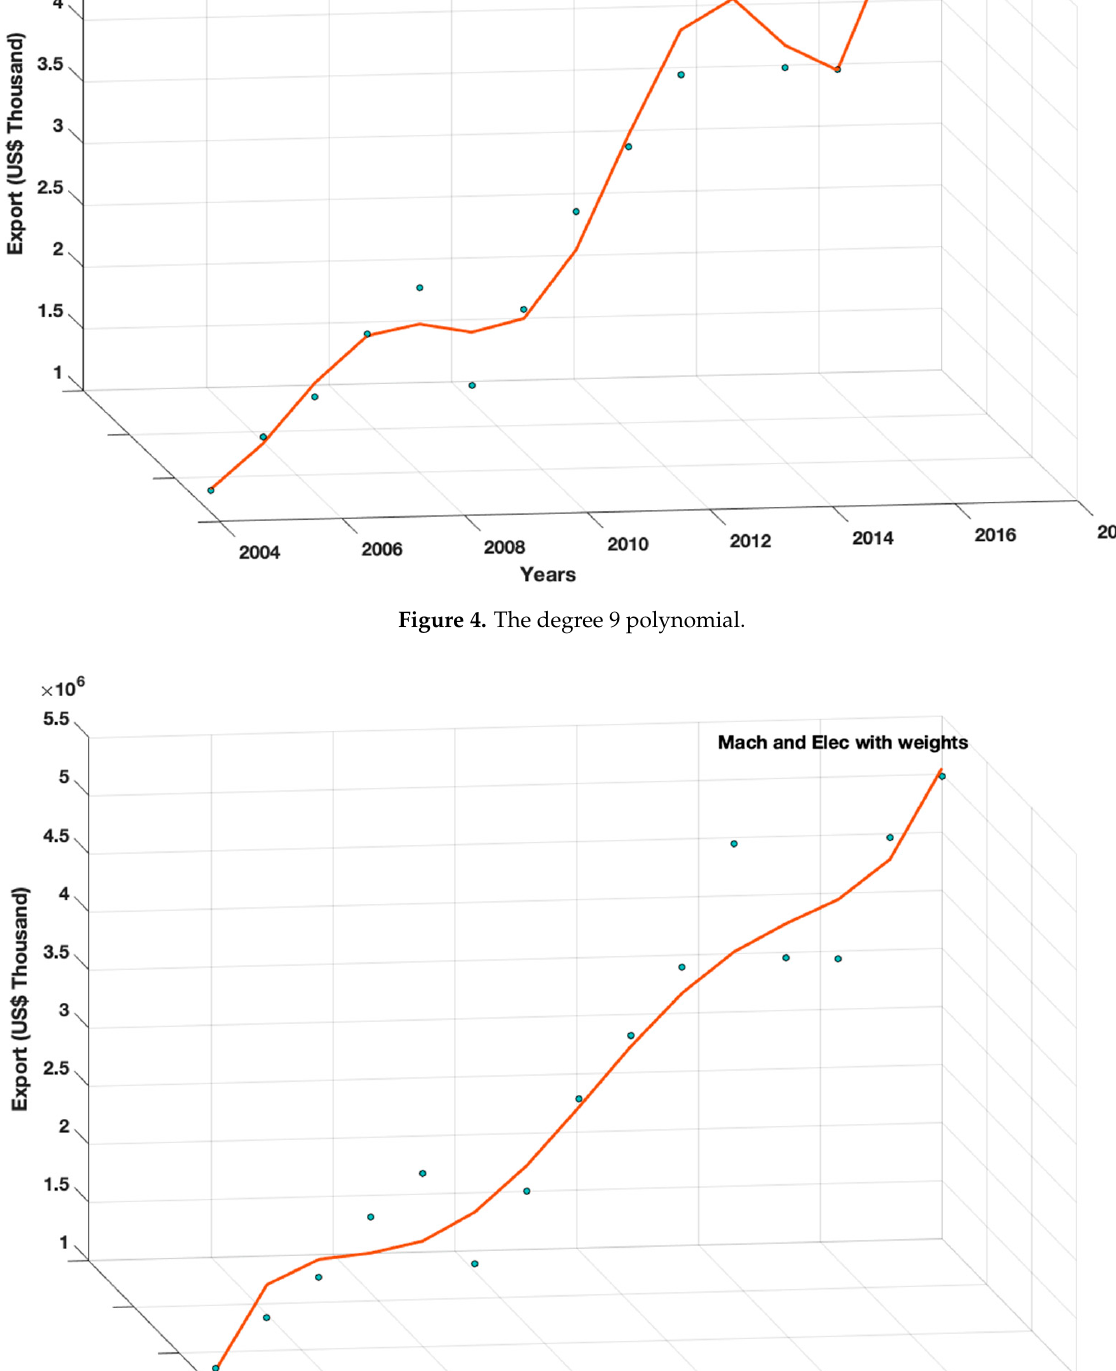
Figure 5. The degree 6 polynomial with weights.